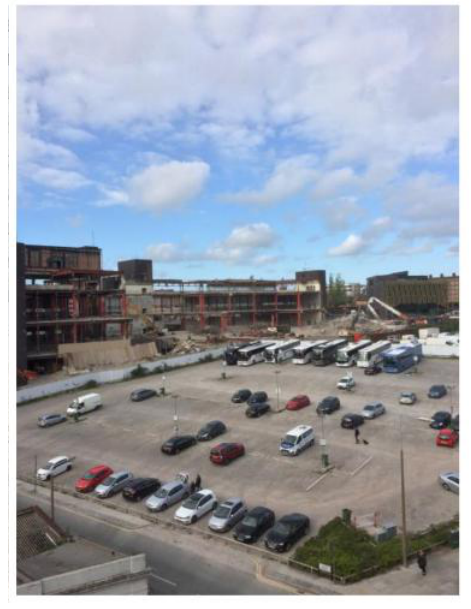
Figure 3. Car Park